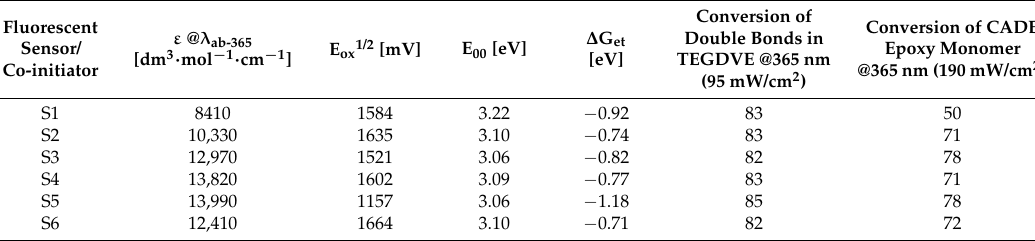
Table 4. Functional group conversions of vinyl monomer for TEGDVE and epoxy monomer for CADE and using photoinitiating system based on diphenyliodonium hexafluorophosphate (HIP wt 1%)